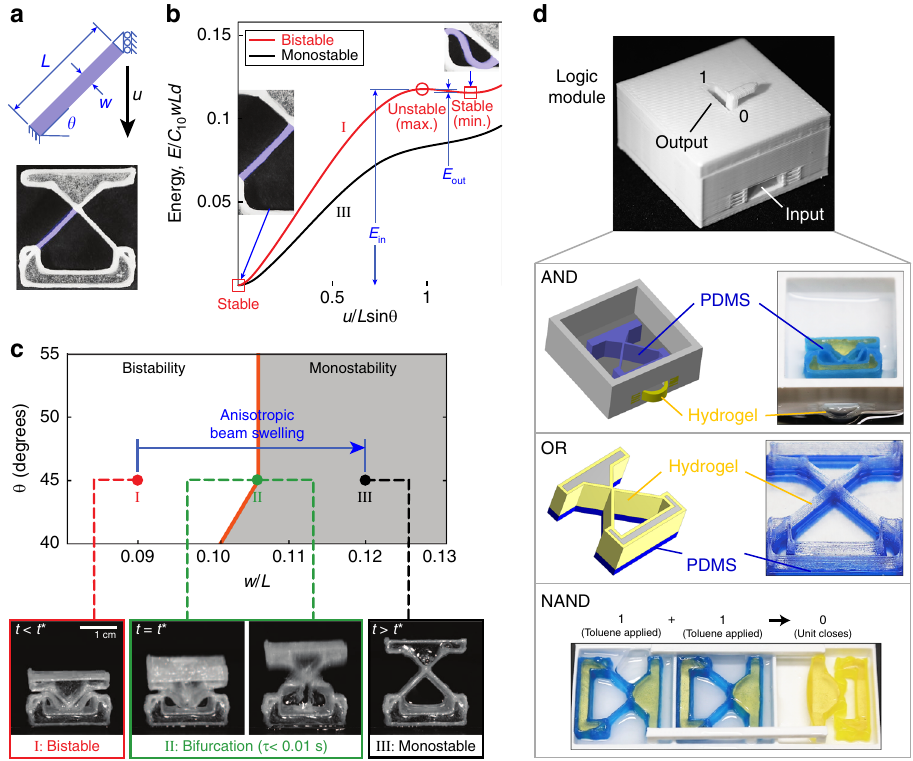
Fig. 1 Overview of bifurcation-based actuation. a Schematic and photo of beams, with key geometric parameters and boundary conditions. b The normalized strain energy, E /( C 10 wLd ), where C 10 is a material parameter in the Holzapfel – Gasser – Ogden (HGO) model 65 and d is the out-of-plane thickness of the beam; plots are included for a bistable beam (red curve, I) and a monostable beam (black curve, III) as a function of normalized displacement, u/Lsin θ , obtained via fi nite element simulations (Supplementary Note 5). Inset: photos of the undeformed ( u = 0) and buckled con fi gurations, corresponding to the two stable points (energy minima) on the bistable curve; the monostable curve has only the single minimum at u = 0. c Geometric phase diagram mapping geometric parameters to mechanical behavior, with schematic overlay indicating the transition from bistable to monostable (point I to point III) due to anisotropic swelling of the beams. Also shown are representative images recorded with a high-speed camera during actuation showing a unit when it is bistable (red), at the point of bifurcation when actuation occurs (green), and monostable (black). d A logic module which can act as one of several types of logic gates depending on the contents of the module. An AND gate can be constructed by using a hydrogel valve and a PDMS-GF15 bistable unit (requiring both water and toluene to switch from 0 to 1). An OR gate can be constructed by fabricating a composite bistable unit from both PDMS-GF5 (blue) and hydrogel (transparent) materials (this actuates if either water or toluene is applied); a functionally-complete NAND gate can be constructed by connecting two “ input ” bistable units to one “ output ” unit. In this case, only when toluene is applied to both input units will the output unit close from 1 to 0 (i.e., 1 + 1 →